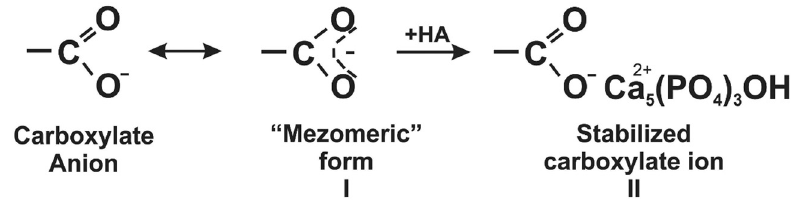
Figure 8: The mezomeric form of the stable carboxylic group during mineralization.